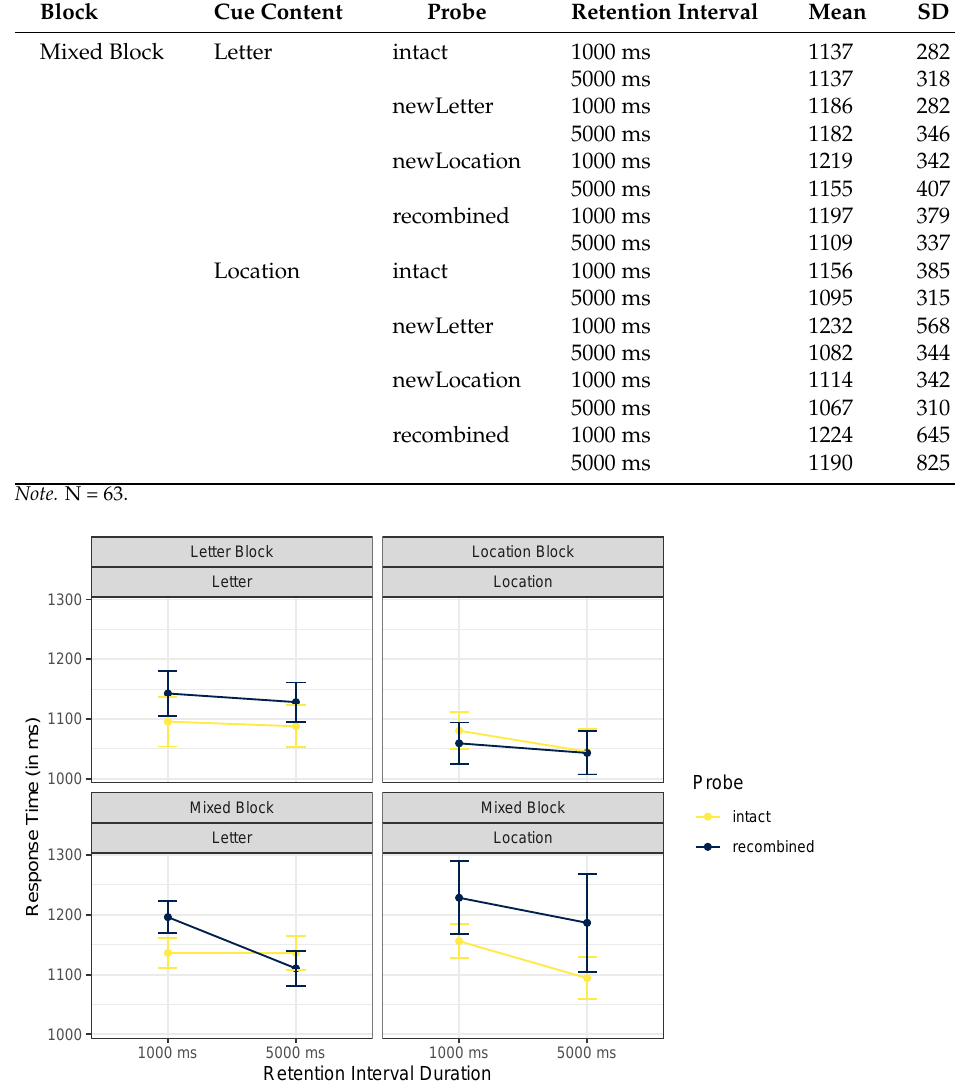
Figure 5. Mean trimmed reaction times, Experiment 2. Error bars mark within-participant standard errors around the mean calculated with the Cousineau–Morey method